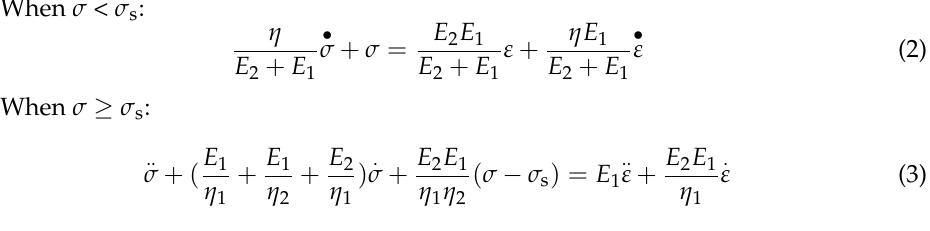
Figure 8. Nishihara model.